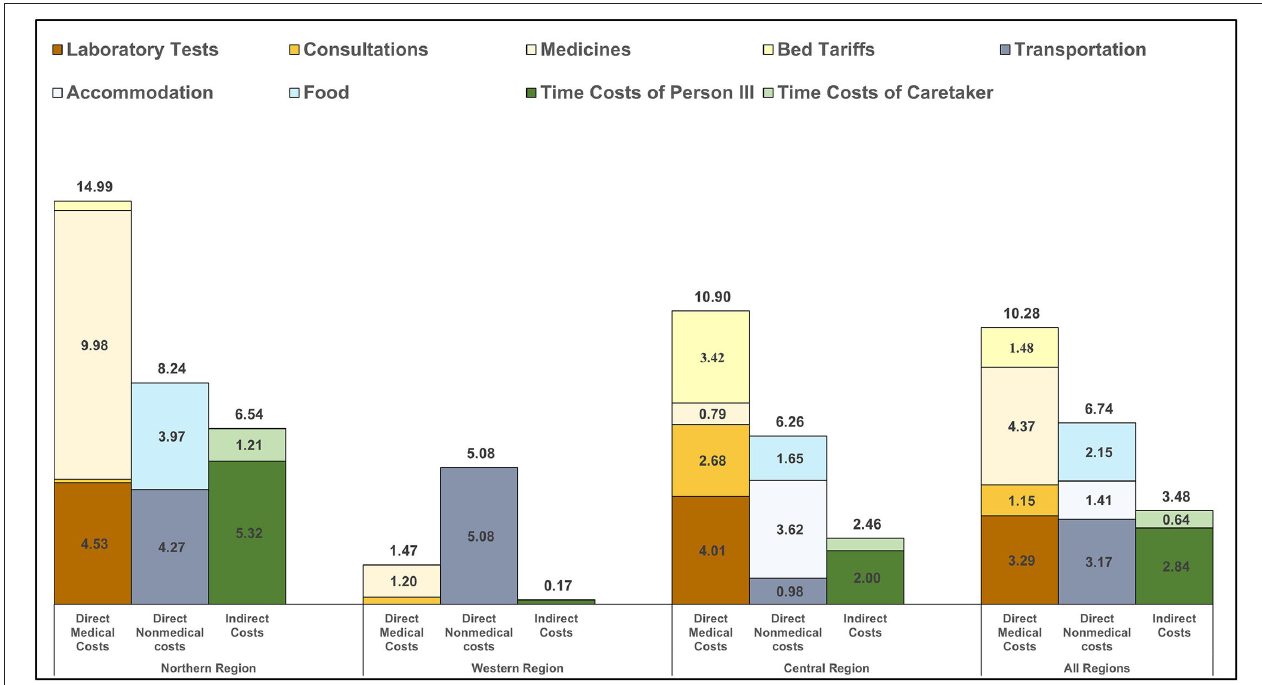
FIGURE 2 | Inpatient costs incurred from receiving care for RHD. The bar graphs show the level and distribution of average costs per person per year for inpatient encounters ( n = 27). Eleven participants from the Northern Region represented seventeen visits; two participants from the Western Region represented two visits; and eight participants from the Central Region represented eight visits. Costs are disaggregated by region and by component and include direct and indirect costs. Note: costs are presented in 2019 United States dollars.